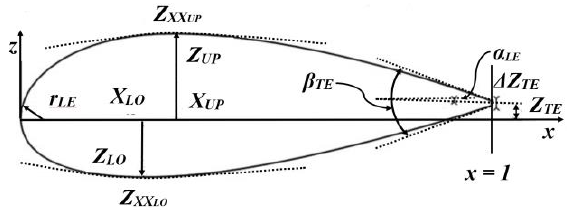
Figure 1. Parsec method.